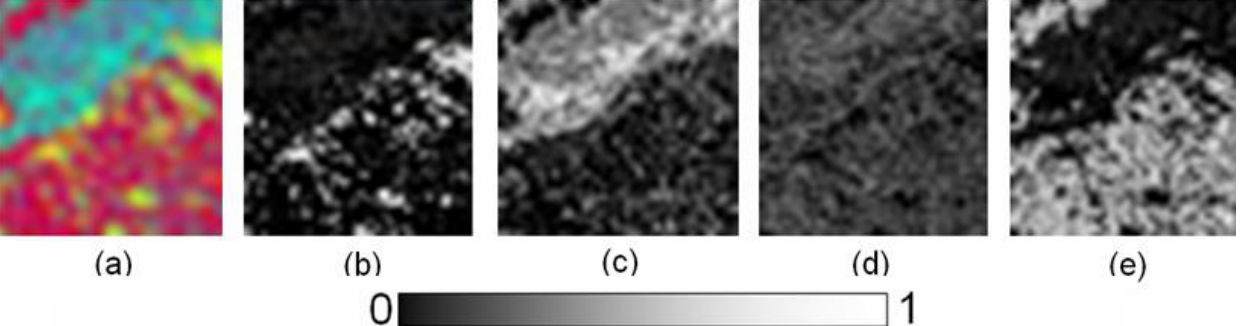
Figure 7. ( a ) Ten times down-sampled image of the original mineral classified image; ( b) – (e ) abundances maps of the four minerals obtained from linear mixture model